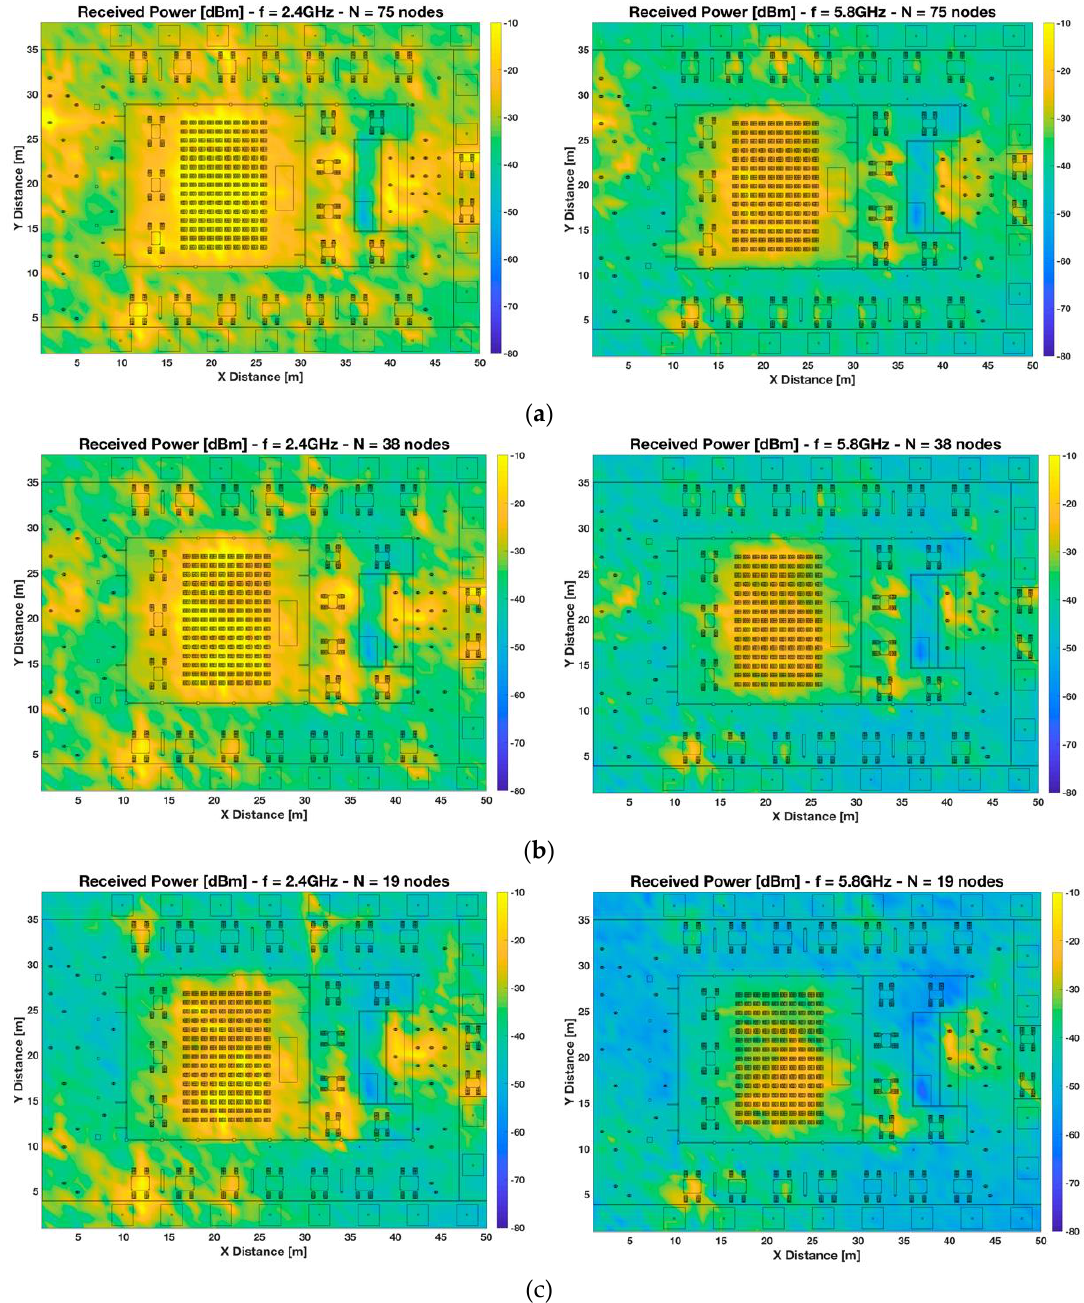
Figure 3. Bi-dimensional planes of received power [dBm] at 1.2 m height at 2.4 GHz and 5.8 GHz frequency bands. Different scenario setups have been considered: ( a ) high-node density scenario, ( b ) medium-node density scenario, and ( c ) low-node density scenario.